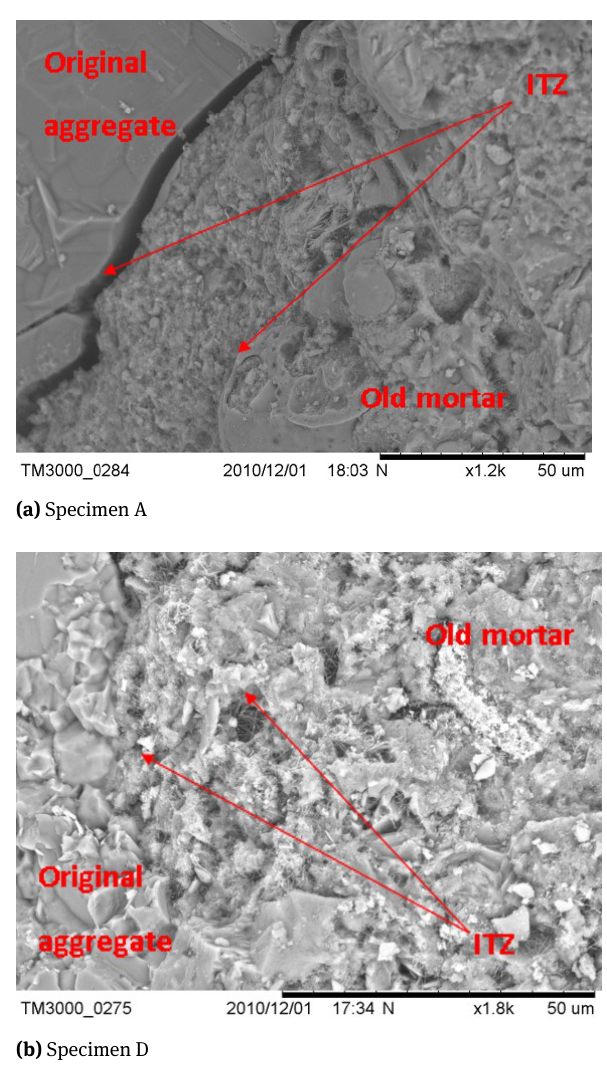
Figure 12: SEM images of ITZ between original aggregate and old mortar in specimen A and